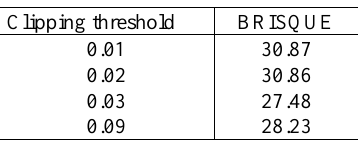
Table 2. BRISQUE scores of the output images generated with Contrast-Limited Adaptive Histogram Equalization algorithm with four clipping threshold values.